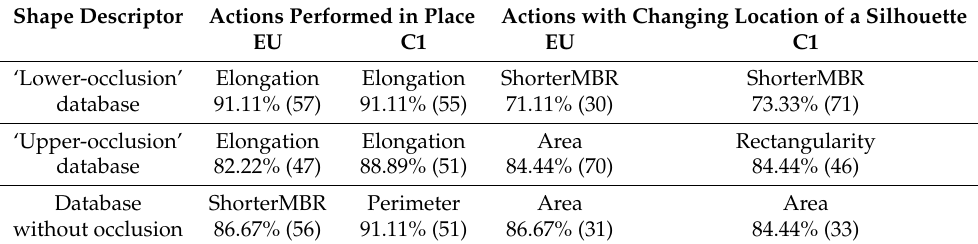
Table 3. Summary of the results obtained using databases with or without